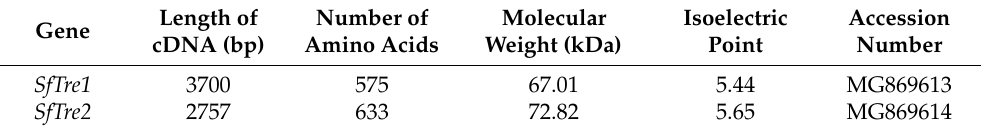
Table 2. Sequence information of SfTre1 and SfTre2